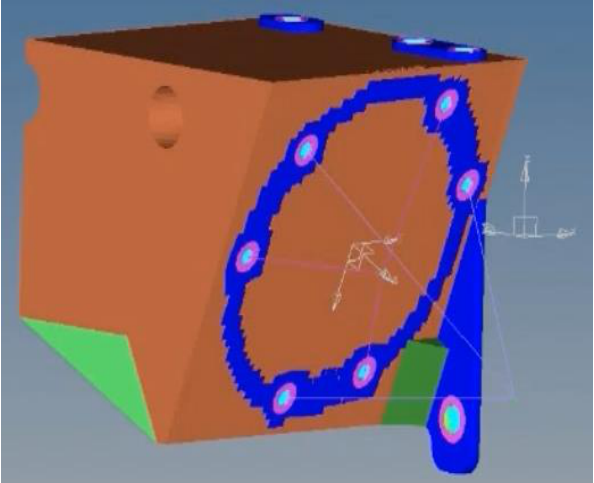
Figure 6. Design space for the Star Camera Bracket Topology Optimization Routine.